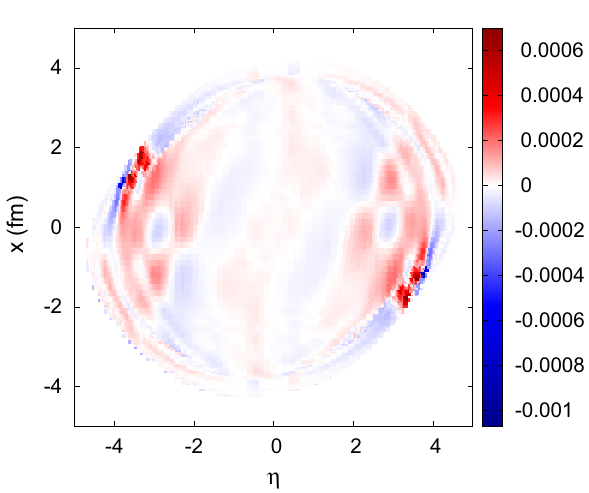
Fig. 3 Contour plot of Ω x η /τ T 2 at the freeze-out hypersurface at y =